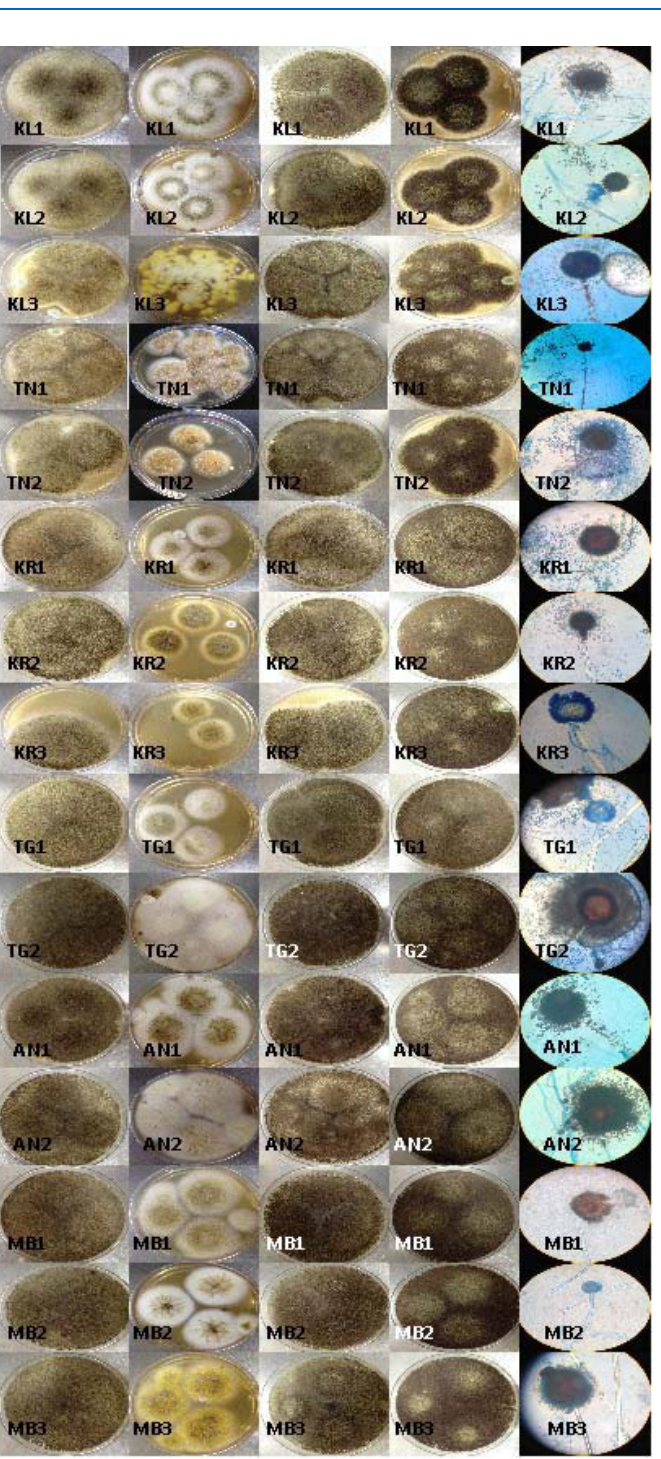
Fig. 2. Isolates of Aspergillus tamarii grown on CYA 25°C, G25N 25°C, CYA 37°C, CY20S 25°C and microscopic